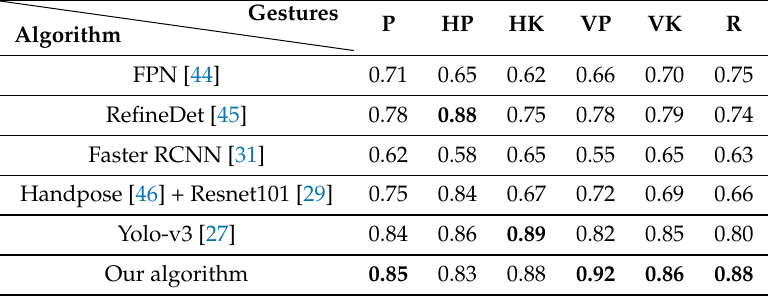
Figure 21. The RPC analysis results based on our own dataset. Table 5. Recall Rate of different algorithm when on the NYU test data when precision is set as 0.98. (“P” represents gesture Paper, “HP” represents gesture Horizontal Palm, “HK” represents gesture Horizontal Knife, “VP” represents gesture Vertical Palm, “VK” represents gesture Vertical Knife, “R” represents gesture Rock).